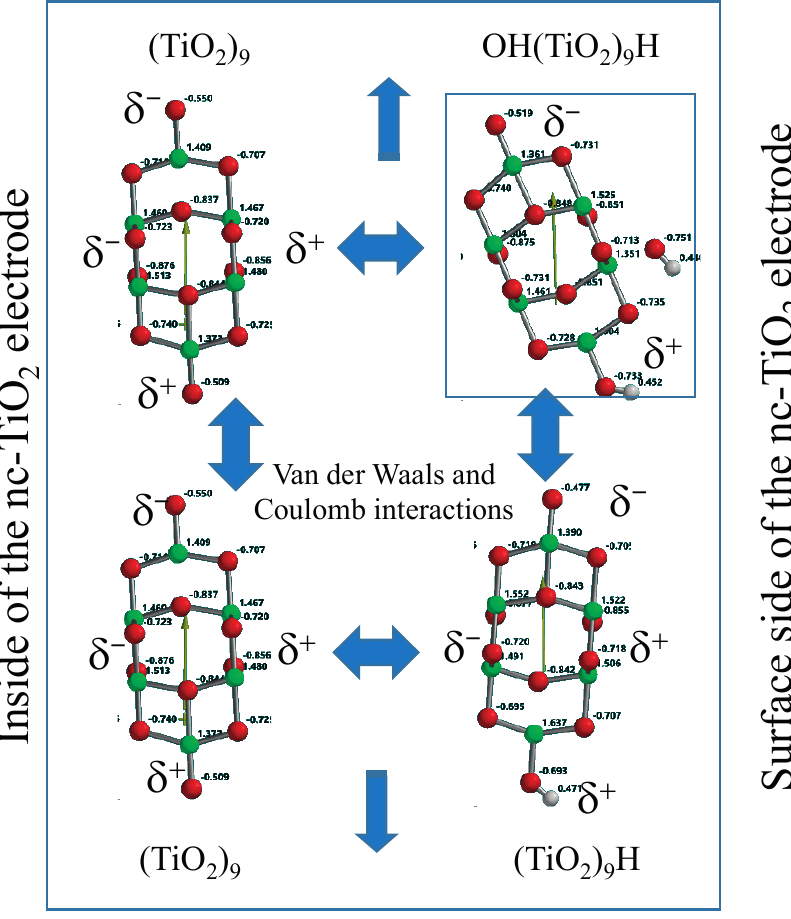
Figure 2. Association of Yamashita/Jono model via van der Waals and Coulomb interactions, explaining growth of the model to larger size PEC-nc-TiO 2 electrodes 2.2. Water Cluster Models for Modeling of Interface Structures of PEC-nc-TiO 2